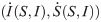
Phase portrait of the uncontrolled SIR model.Phase portrait, (I˙(S,I),S˙(S,I)), for the uncontrolled SIR model (α = 0) with finite immune response (Eq 24). The solid green curve shows a trajectory in phase III, with initial conditions (circle) I0 = Ih (capacity limit) and S0 = 1/R0 (herd immunity), The dashed curves (orange) show the nullclines, I˙=0 (for S = 1/R0 or I = 0), and S˙=0 (for S = (1 − I)/(IR0
ρ/τ + 1)). The stable fixed point (diamond) is given by I∞=I^h, S∞ = 1/R0. Parameters: R0 = 3, ρ/τ = 93, Ih = 0.01.